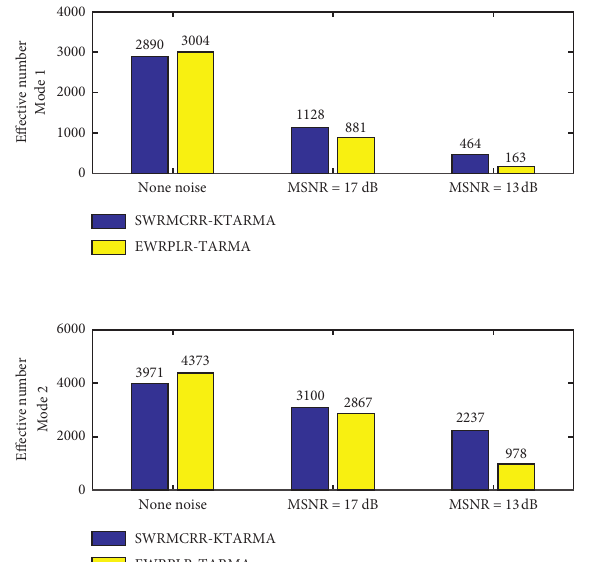
Figure 8: The average effective number of modal frequency estimates based on the experimental response signal with added numerical noise for all 10 Monte Carlo runs.